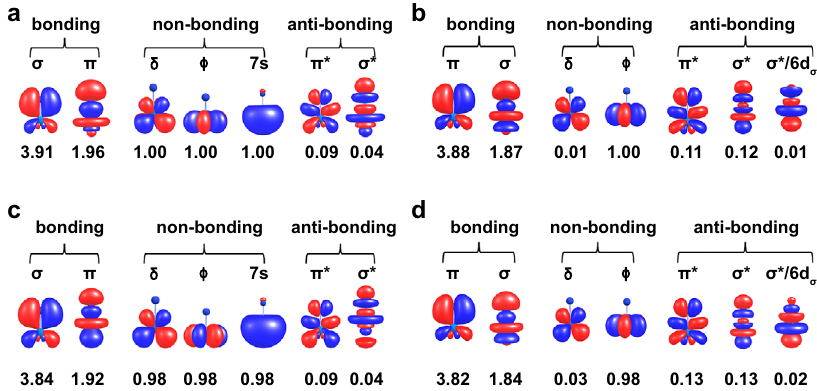
Fig. 6 | Natural orbitals and populations from wavefunction calculations for UN and UN 2+ . Natural Orbital (NO) isosurfaces (±0.04 a.u.) and populations cal- culated for the Λ =3 4 H ground state of UN without ( a ) and with PT2 treatment of dynamiccorrelation( c ).NOisosurfaces(±0.04a.u.)andpopulationscalculatedfor